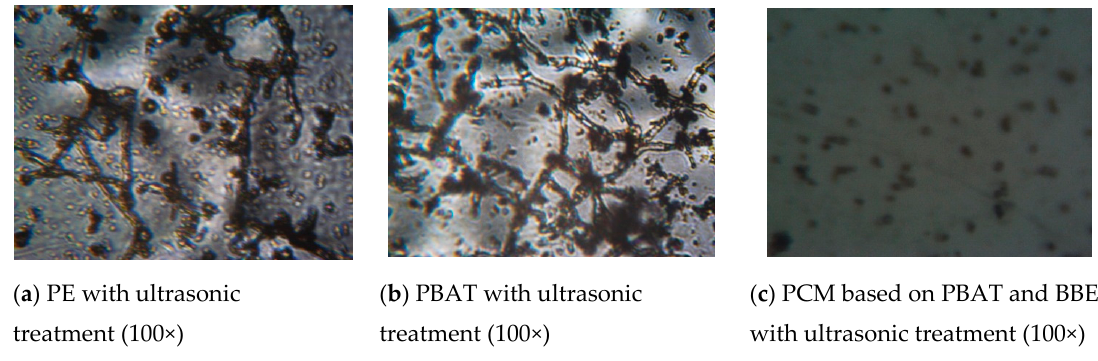
Figure 5. Micrographs of the surface of inoculated materials on the 14th day of exposure to Aspergillus niger .